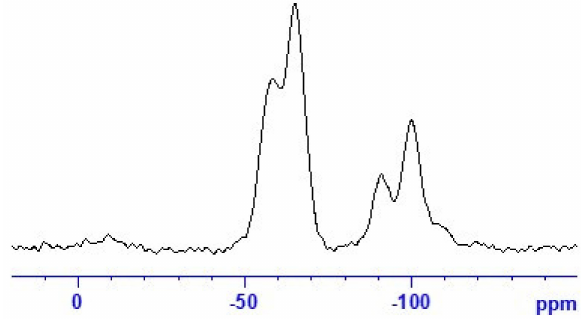
Figure 4. 29 Si CP / MAS NMR spectra of the hybrid DACHsilane fibres. Table 2. Composition of the siloxane fraction defined as the total amount of individual T n and Q n structure units in molar